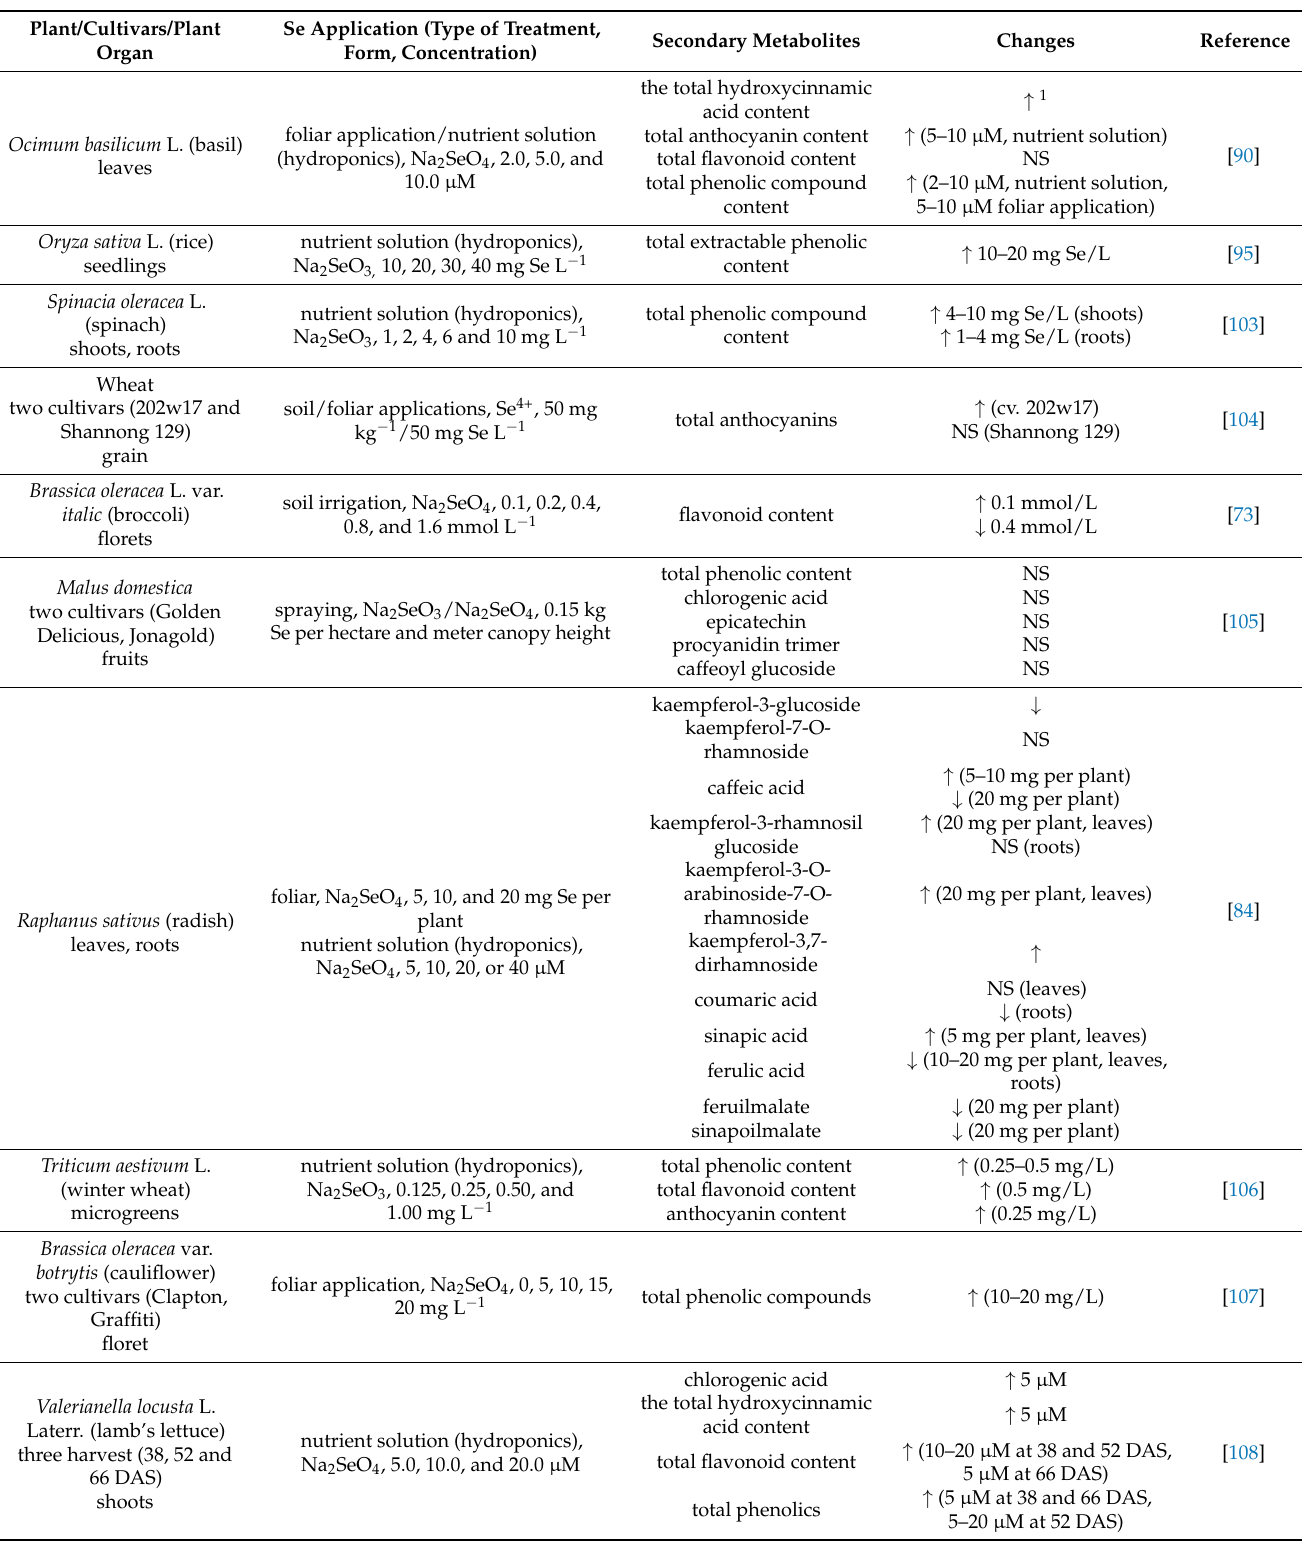
Table 3. Effect of Se application on the accumulation of phenolic